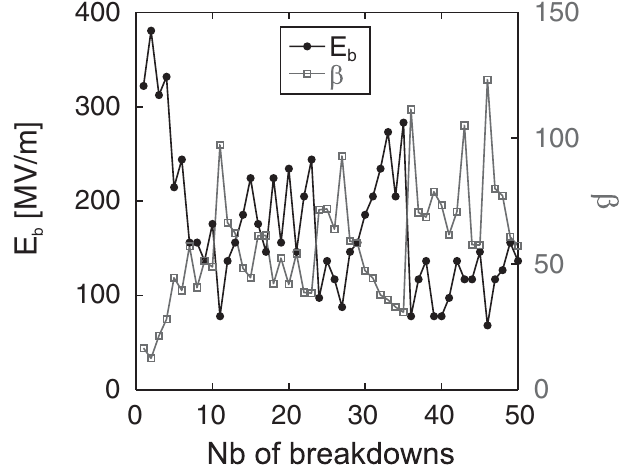
FIG. 2. Evolution of the field enhancement factor (cid:1) and the subsequent breakdown field E b with Cu electrodes during a conditioning